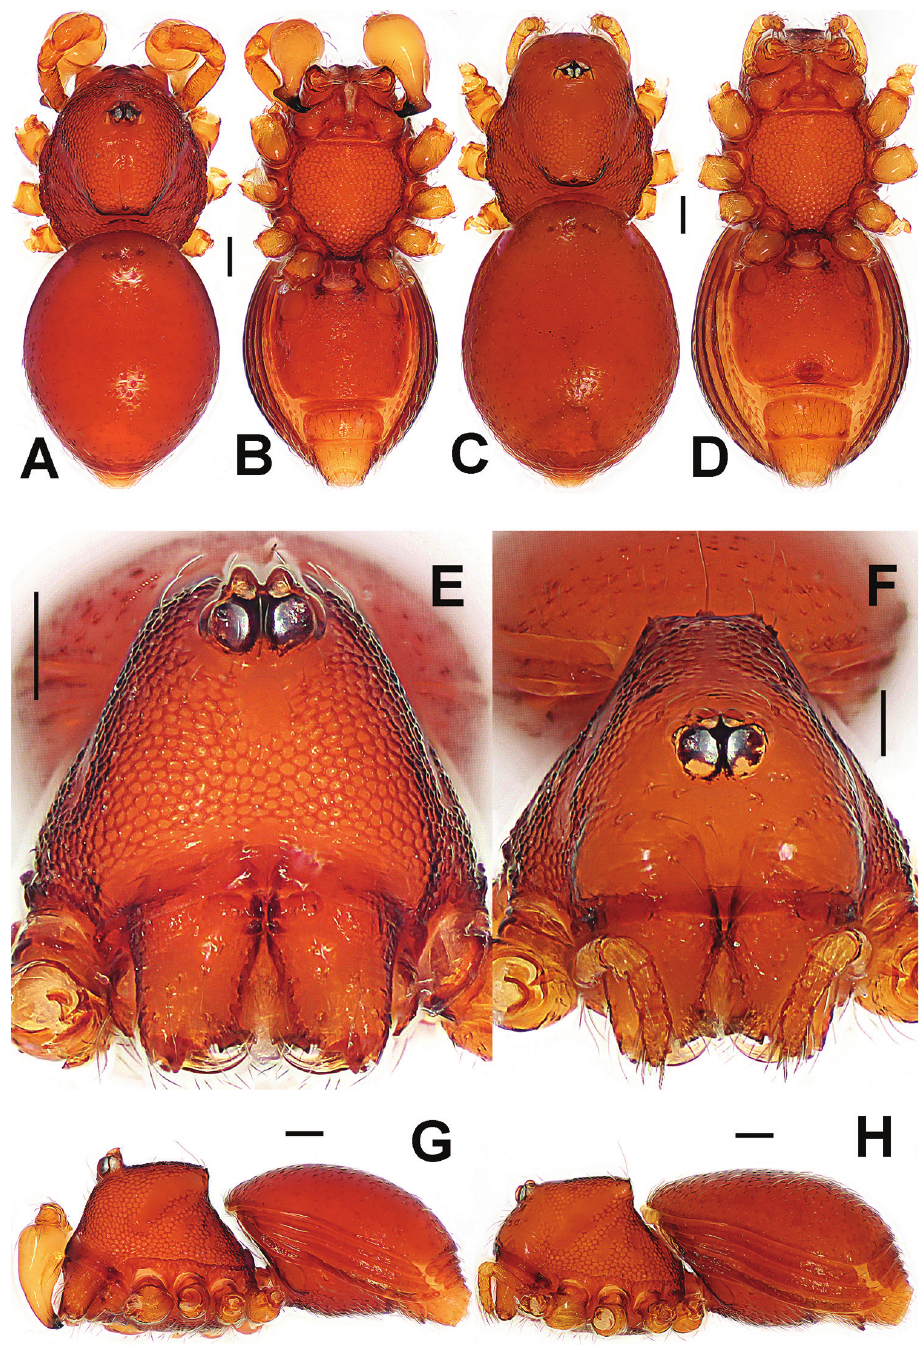
Figure 7. Ablemma malacca sp. n., male holotype ( A–B, E, G ) and female paratype ( C–D, F, H ). A–D, G–H habitus E–F prosoma. A, C dorsal B, D ventral E–F anterior G–H lateral. Scale bars: 0.10